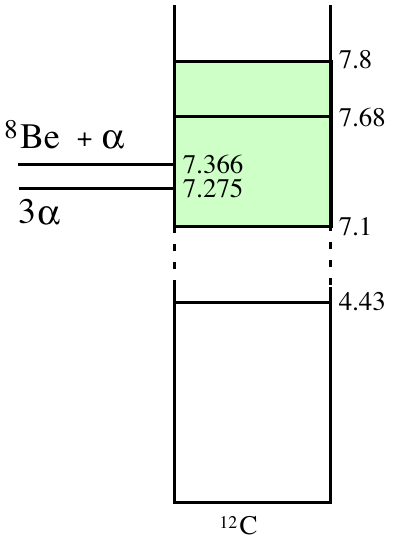
Figure 8.6: The energy levels of Figure 6: The structure of the 12 C nucleus as known the 12 C nucleus relative to the in 1940. The level at 7.68MeV can decay into a 8 Be+ α or 3 α . The green color spans the range where the var- rest mass energy of 8 Be + ↵ and ious experiments gave an indication of an energy level. 3 ↵ . The level at 7 . 68MeV can de- All energies are in cay into a 8 Be + ↵ or 3 ↵ . The green color span the range where the various experiments gave an indication of an energy level. All